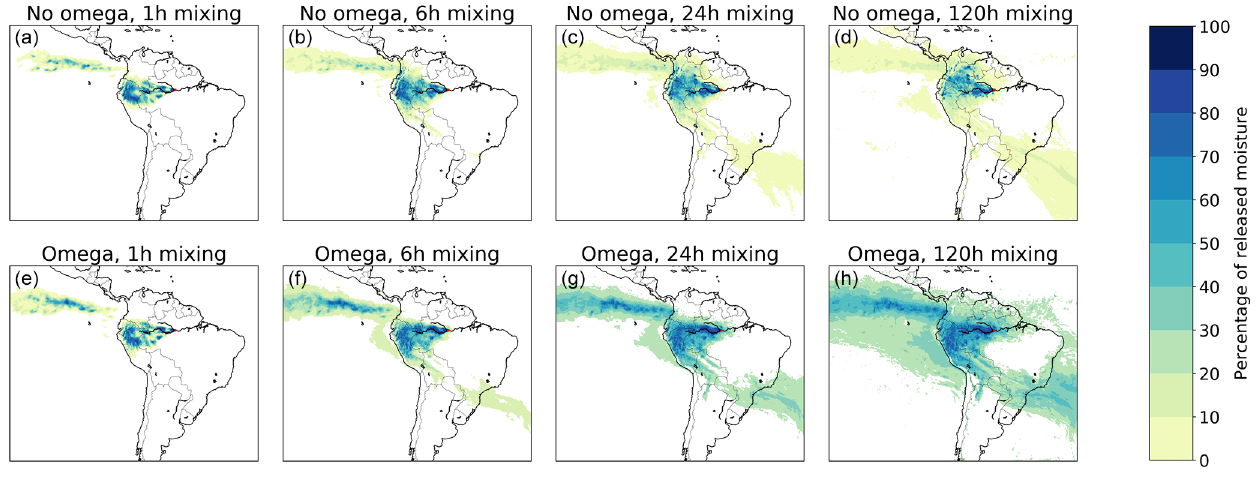
Figure 10. Different footprints of moisture releases from Manaus in July 2012 in a three-dimensional Lagrangian model with different mixing assumptions: without and with accounting for the three-dimensional moisture flows in the ERA5 data (termed omega), and with different assumptions of additional vertical mixing speed (full mixing every 1h, every 6h, every 24h, and every 120h). (a) Without omega, every 1h mixing, with a mean latitudinal moisture flow of 2.4 ◦ in a northerly direction and mean longitudinal flow of 16.4 ◦ in a westerly direction; (b) without omega, every 6h mixing, with a mean latitudinal moisture flow of 1.4 ◦ in a northerly direction and mean longitudinal flow of 14.3 ◦ in a westerly direction; (c) without omega, every 24h mixing, with a mean latitudinal moisture flow of 0.1 ◦ in a northerly direction and mean longitudinal flow of 11.6 ◦ in a westerly direction; (d) without omega, every 120h mixing, with a mean latitudinal moisture flow of 1.2 ◦ in a northerly direction and mean longitudinal flow of 9.0 ◦ in a westerly direction; (e) with omega, every 1h mixing, with a mean latitudinal moisture flow of 3.0 ◦ in a northerly direction and mean longitudinal flow of 16.7 ◦ in a westerly direction; (f) with omega, every 6h mixing, with a mean latitudinal moisture flow of 0.3 ◦ in a northerly direction and mean longitudinal flow of 14.5 ◦ in a westerly direction; (g) with omega, every 24h mixing, with a mean latitudinal moisture flow of 5.0 ◦ in a northerly direction and mean longitudinal flow of 12.3 ◦ in a westerly direction; (h) with omega, every 120h mixing, with a mean latitudinal moisture flow of 6.9 ◦ in a northerly direction and mean longitudinal flow of 11.5 ◦ in a westerly